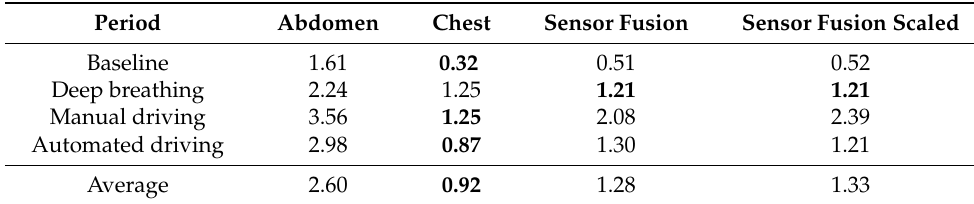
Table 4. Mean absolute error of respiratory rate (in min − 1 ) measured from data collected in the second pretest session, for each sensor and period. Values in bold are the lowest errors achieved by the system for each period and in